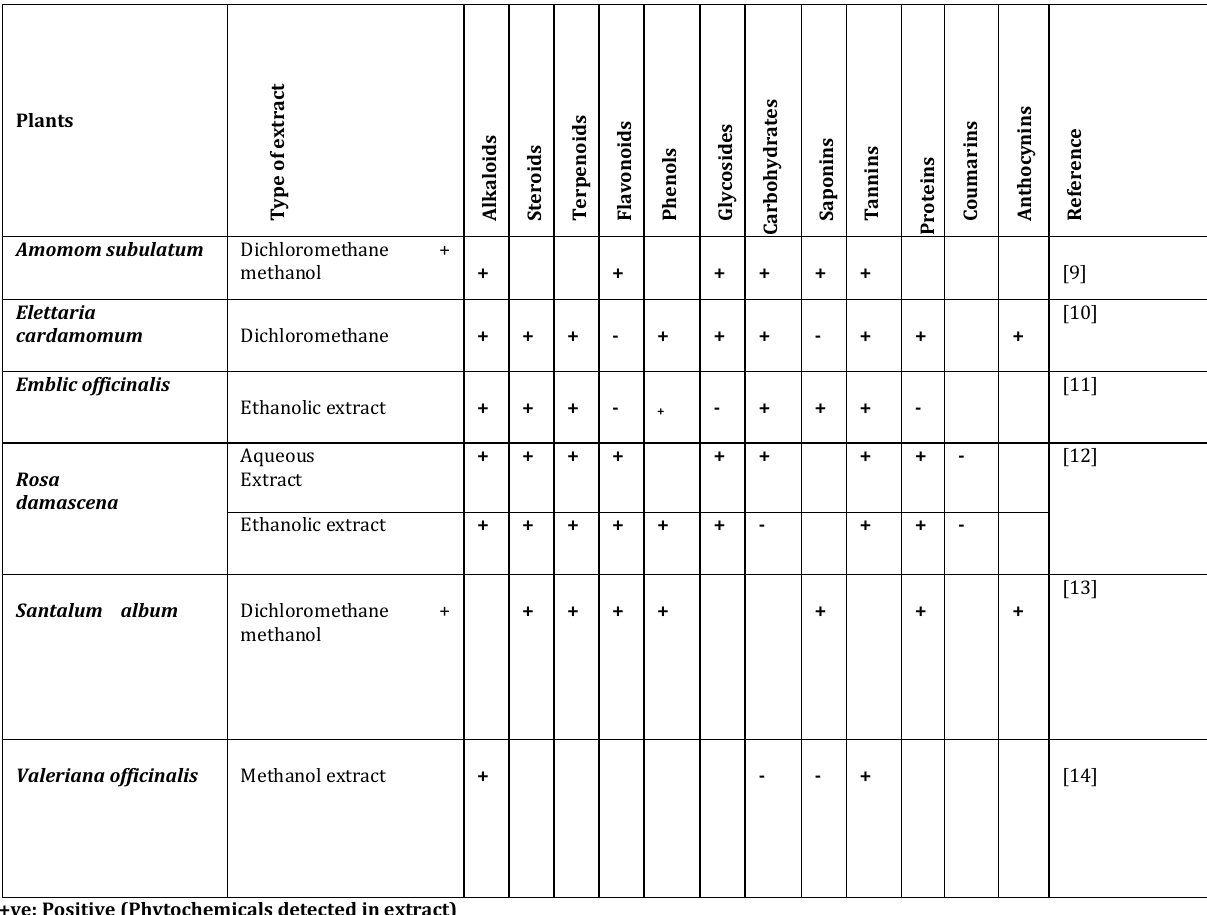
Table 1: Qualitative phytochemical screening of plants